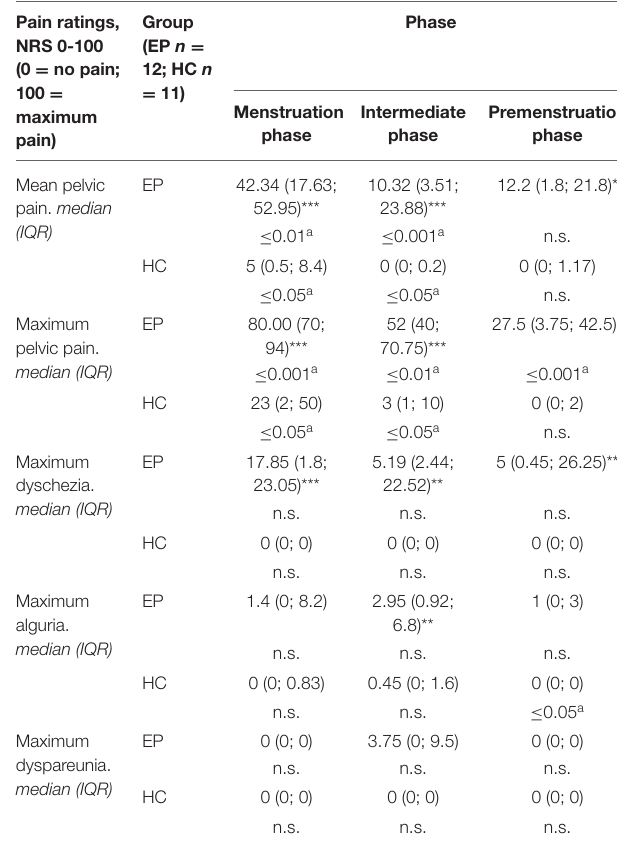
TABLE 2 | Diary results for pain ratings in endometriosis patients and healthy controls, according to cycle